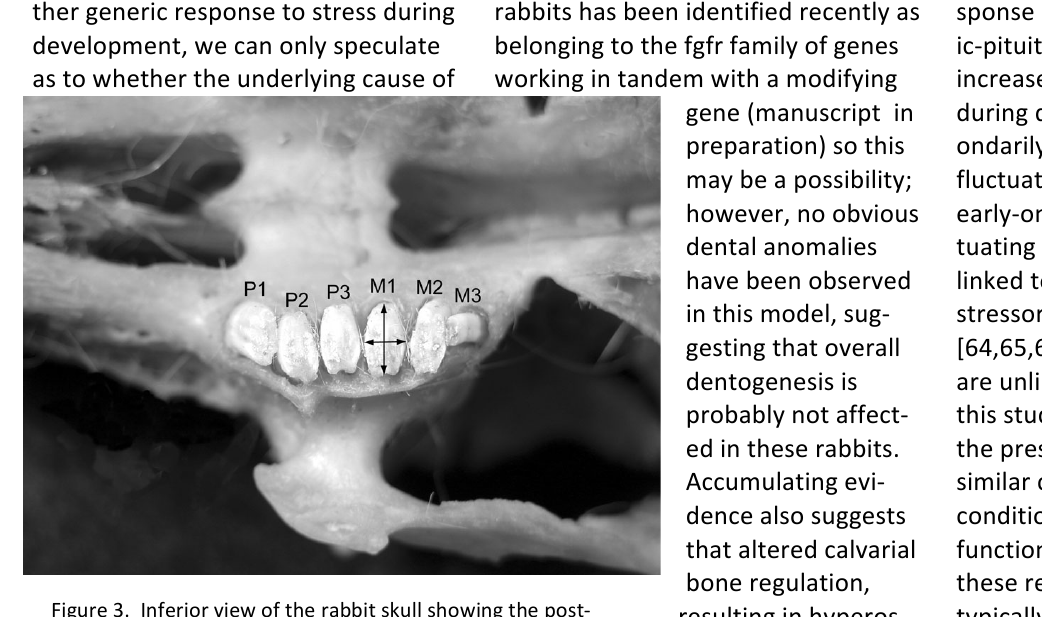
Figure 3. Inferior view of the rabbit skull showing the post-­‐ incisor maxillary dentition (P1-­‐M3) (first three premolars and molars). The arrows on M1 (first molar) represent the mesi-­‐ odistal and buccolingual dimensions that were measured in the present